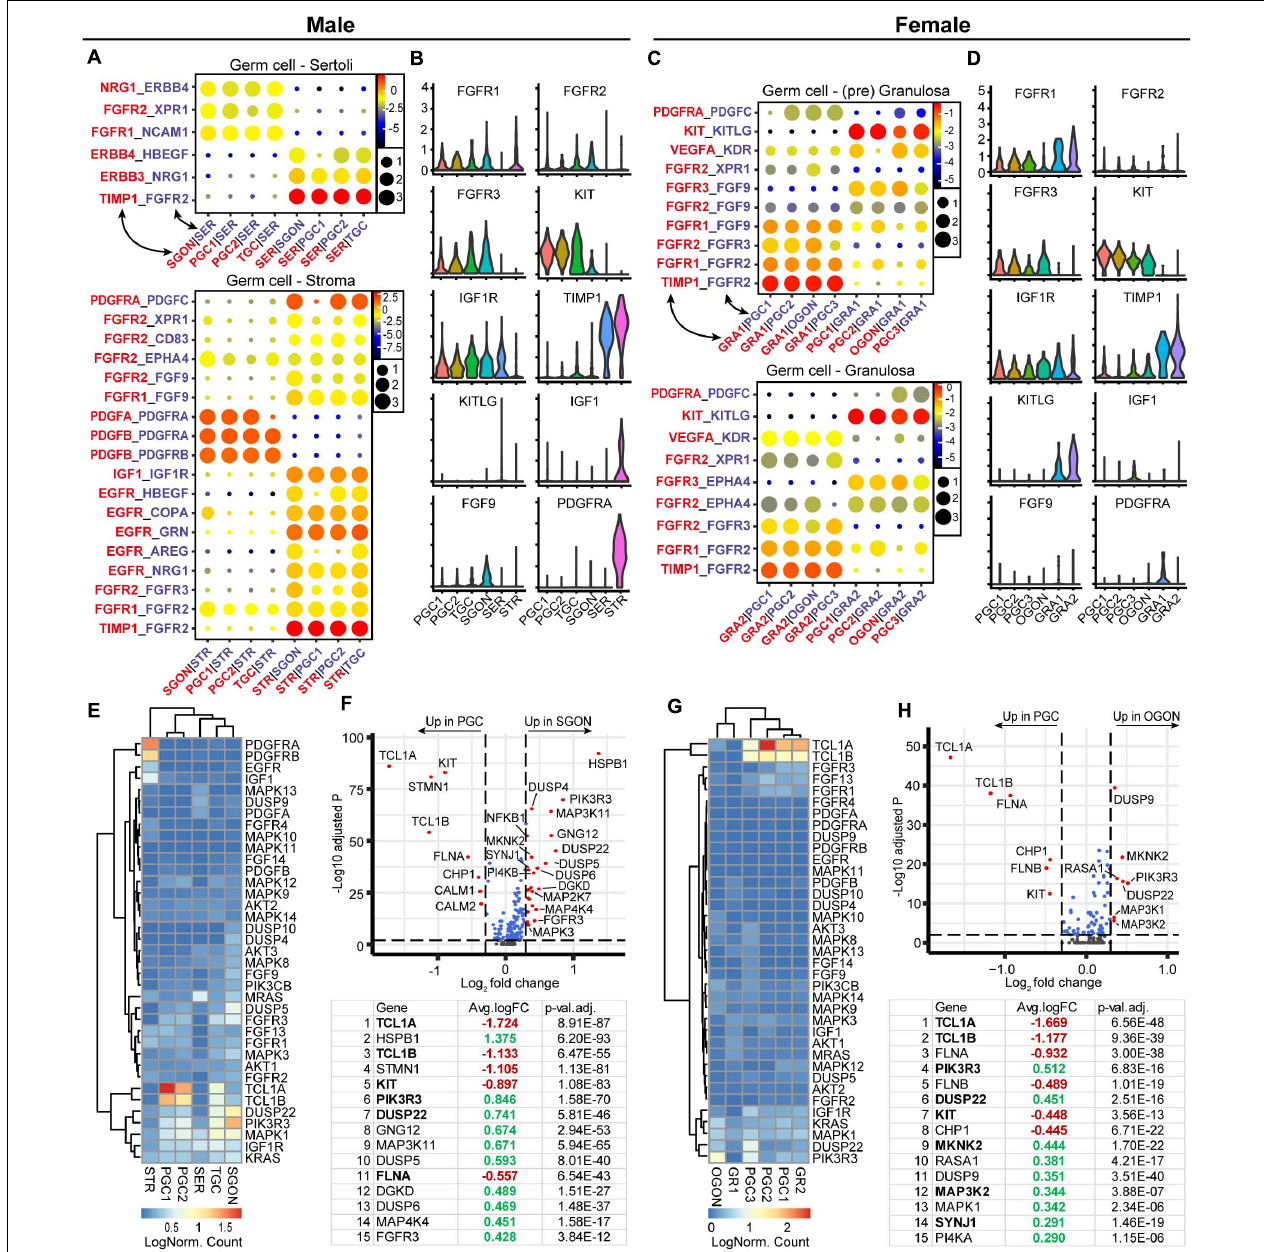
FIGURE 3 | Expression of receptor tyrosine kinases (RTK) ligand–receptor pairs and downstream pathway effectors in fetal gonads. (A) CellphoneDB analysis of RTK interactions between different clusters in male fetal gonads. Depicted are − log 10 p -values (circle size) and log 2 means (circle color) for the interacting pairs, for selected pairwise cluster combinations. (B) Violin plots of selected RTK ligands and receptors in male germ and somatic clusters. (C) CellphoneDB analysis of RTK interactions between different clusters in female fetal gonads. (D) Violin plots of selected RTK ligands and receptors in female germ and somatic clusters. (E) Heatmap showing the expression of genes of interest associated with RTK signaling pathway in male germ and somatic cell clusters. (F) A volcano plot showing RTK-related genes between PGC and GON clusters in male gonads. Table shows the top 15 differentially expressed genes. Genes in bold are common between male and female [see (H) ]. (G) Heatmap showing the expression of genes of interest associated with RTK signaling pathway in female germ and somatic cell clusters. (H) A volcano plot showing RTK-related genes between PGC and GON clusters in female gonads. Table shows the top 15 differentially expressed genes.